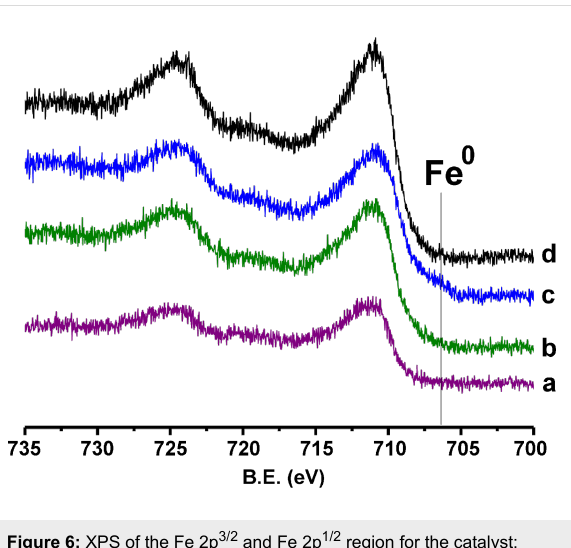
Figure 6: XPS of the Fe 2p 3/2 and Fe 2p 1/2 region for the catalyst: a) after 10 runs, b) after 5 runs, c) as prepared with HDA, d) after 6 runs, followed by H 2